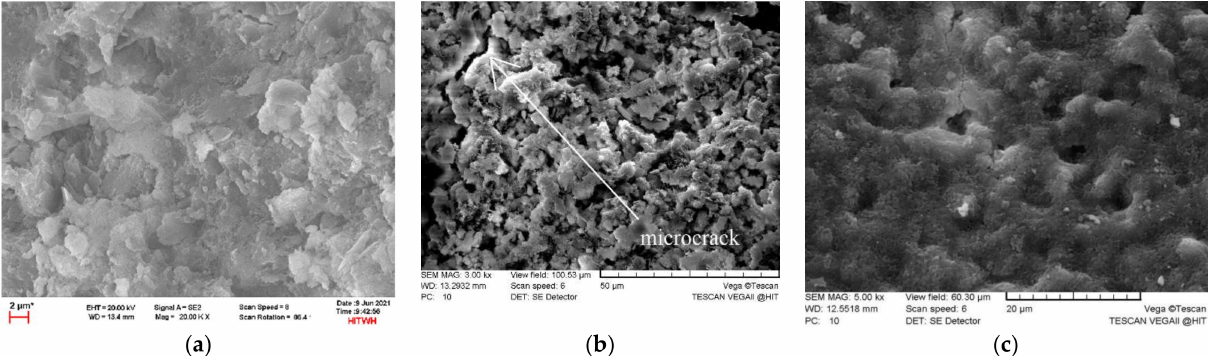
Figure 3. SEM images of the graphene concrete in different CO 2 concentrations. ( a ) No corrosion, ( b ) 8% CO 2 concentration, and ( c ) 10% CO 2